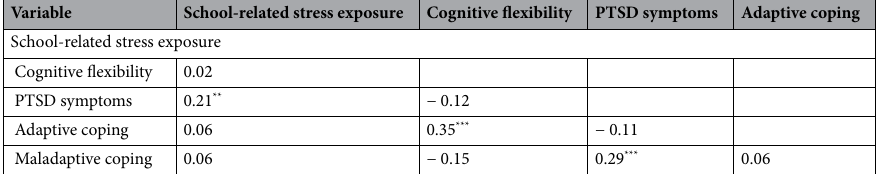
Table 1. Zero-order correlations of the study variables. * p < 0.05, ** p < 0.01, *** p <